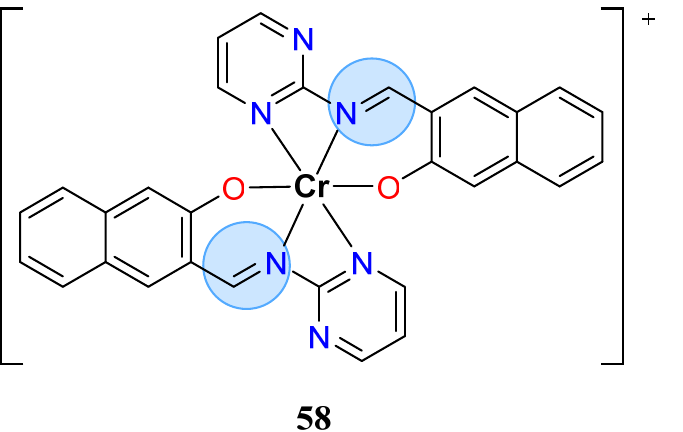
Figure 24. Cr(III) complex from the Schiff base (Pyrimidin-2-yliminomethyl)-naphthalen-2-ol with antibacterial activity.